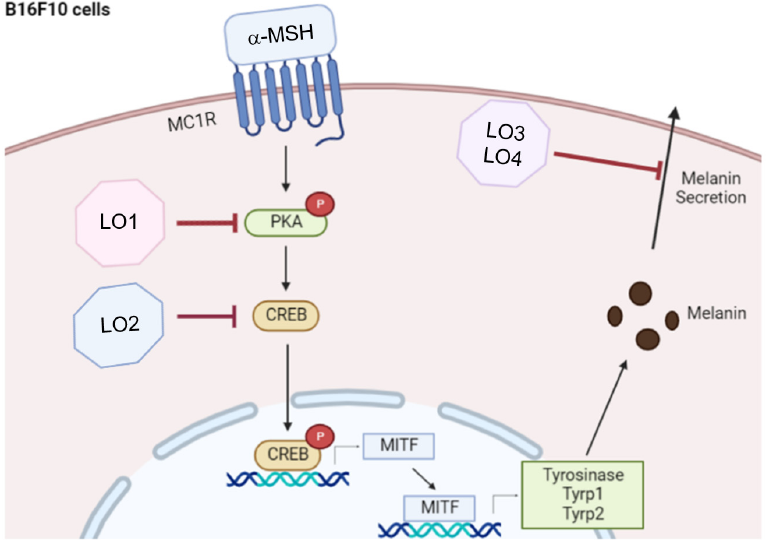
α -MSH-treated B16F10